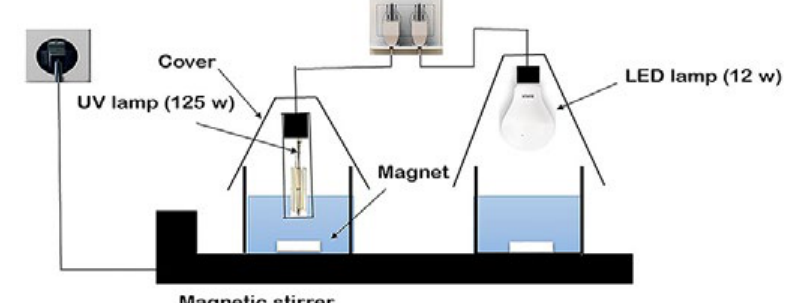
Fig. 2. Experimental setup of AO10 dye